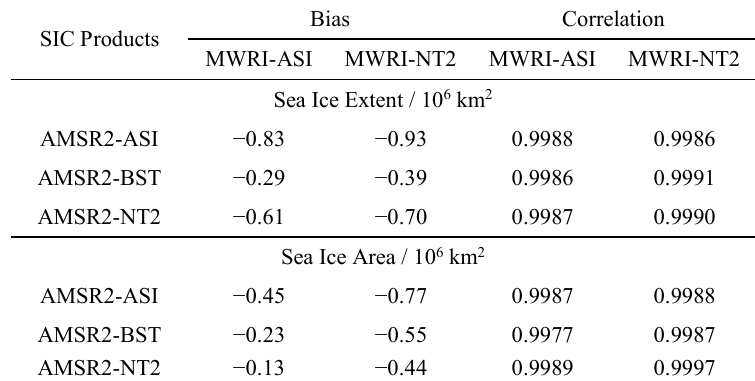
Table 3. Biases and correlations between AMSR2-ASI, AMSR2-BST, AMSR2-NT2 and MWRI-ASI, MWRI-NT2 sea ice extent, sea ice area during 12th July to 31th December in